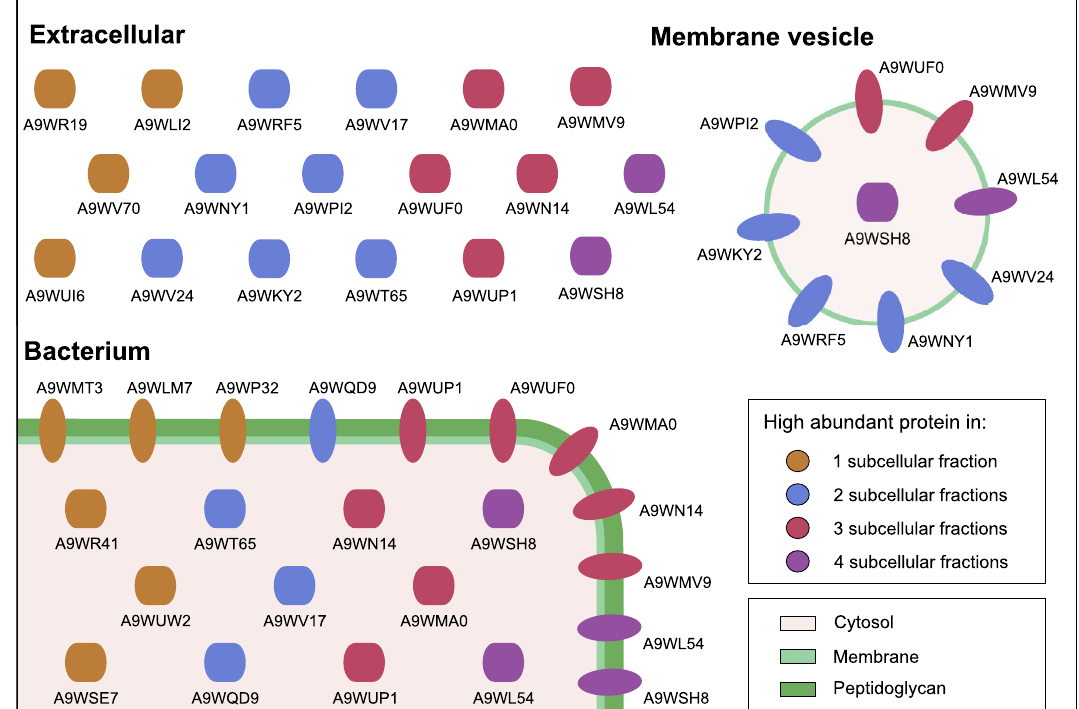
Figure 2. Schematic visualization of 25 high abundant proteins that are involved in virulence processes of R. salmoninarum and their experimental subcellular localization. Proteins are colored depending on their high abundance (higher than a log2 transformed median normalized LFQ intensity of 2) in one or more of the enriched subcellular fractions. Proteins are marked with their UniProt